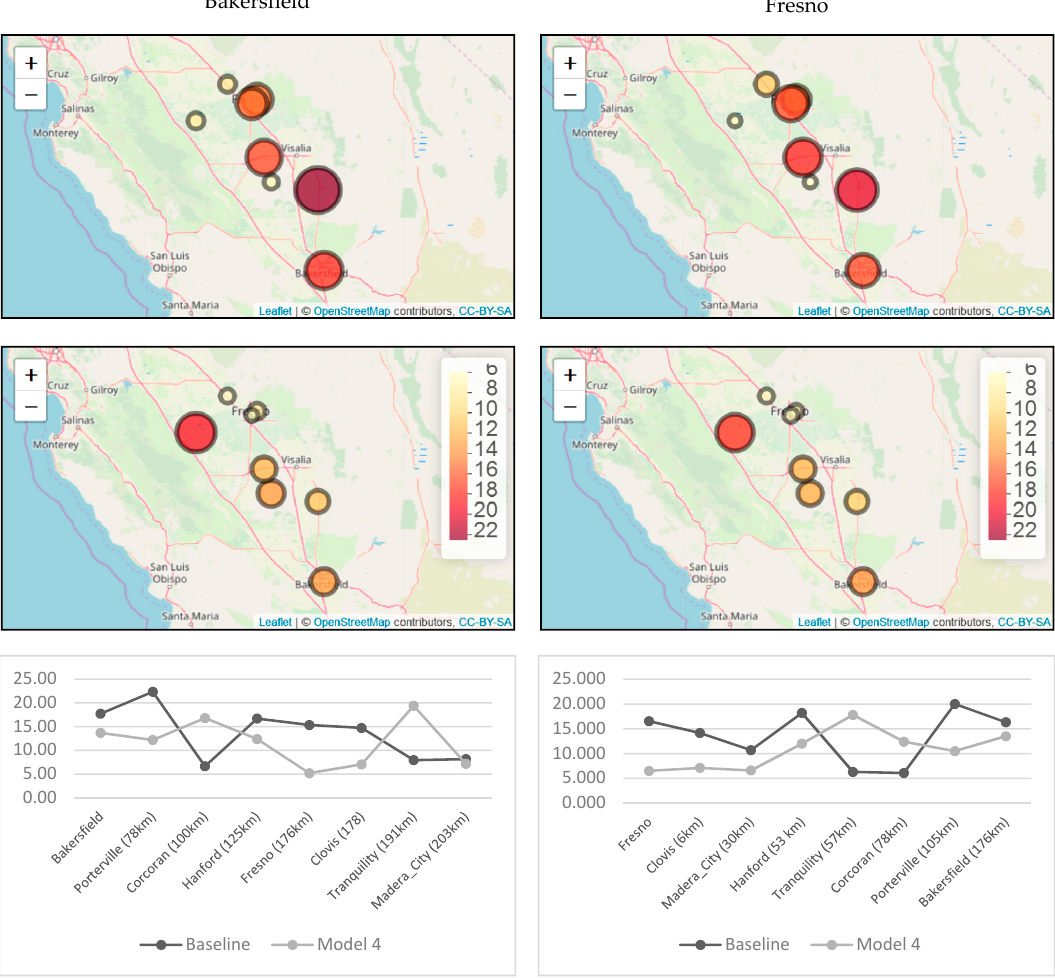
Figure 9. Baseline (top) and Model 4 (middle) calibration models for Bakersfield (N = 249, left) and Fresno (N = 3023, right) showing RMSE (g / m 3 ) by site between observed PM2.5 and the MISR-predicted PM2.5; RMSE (g / m 3 ) ordered by distance from the calibration site are shown in the lower panel. Except for the Tranquility site, there is a clear reduction in the prediction error between the linear regression (Figure 9, upper panel) and Model 4 (Figure 9, center panel) even when calibrating